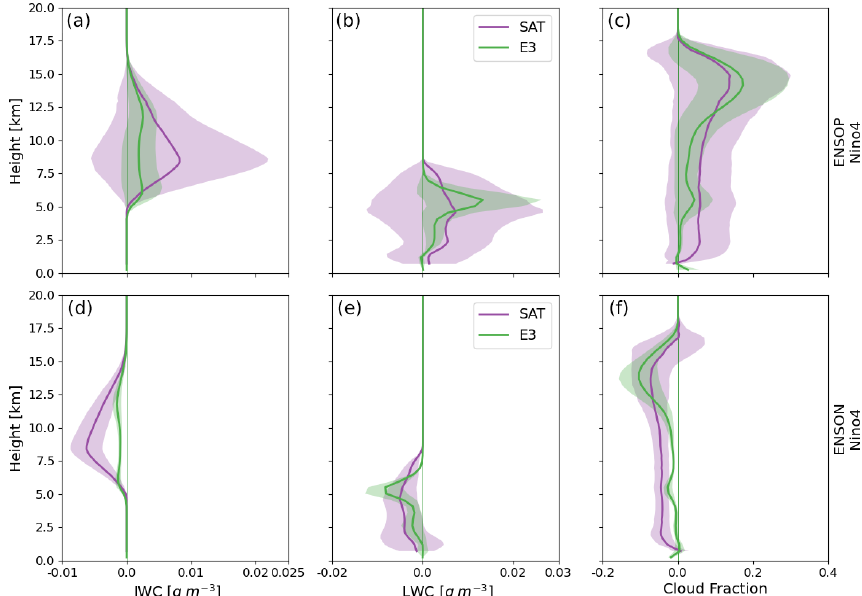
Figure 12. Cloud water content and cloud fraction anomalies for EC-Earth3 (E3) and CloudSat/CALIPSO observations (SAT) averaged over the Niño4 region for both ENSOP (a–c) and ENSON (d–f) . Column 1: ice water content (IWC), column 2: liquid water content (LWC) and column 3: cloud fraction (CF). Shaded areas show ± 1 σ spread based on monthly mean